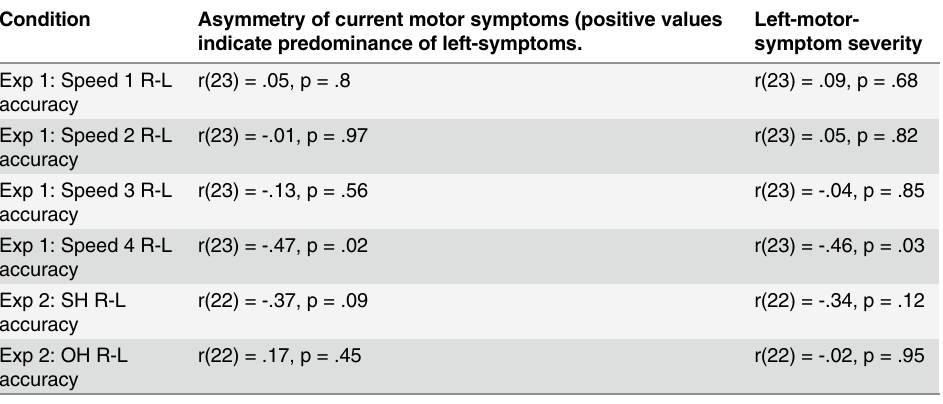
Table 2. Relation between asymmetry of currnet motor symptoms and asymmetry of attentional per- formance. When correcting for 12 comparisons, none of the correlations below are significant, consistent with the analysis based on side of symptom onset reported in the